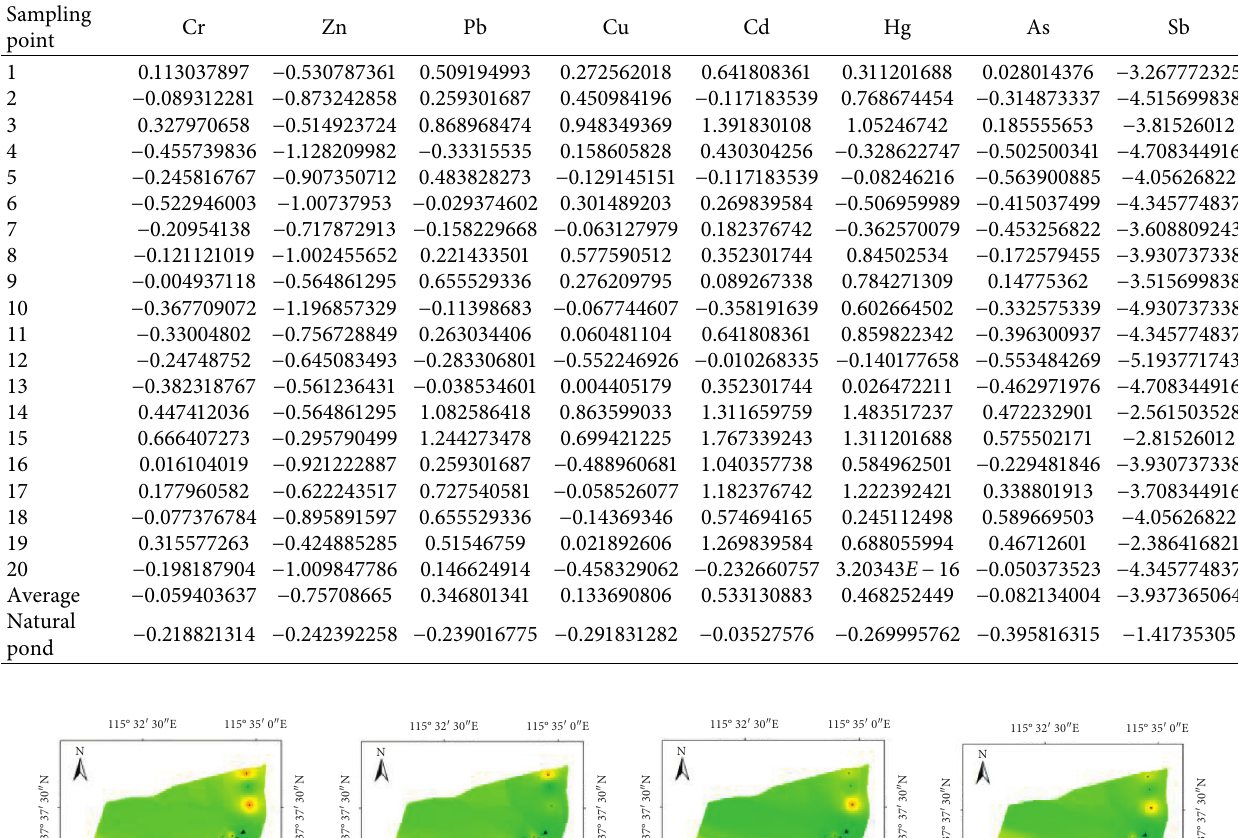
Table 3: I geo of heavy metal elements elements in the sediment at various sampling points in the West Lake of Hengshui Lake.